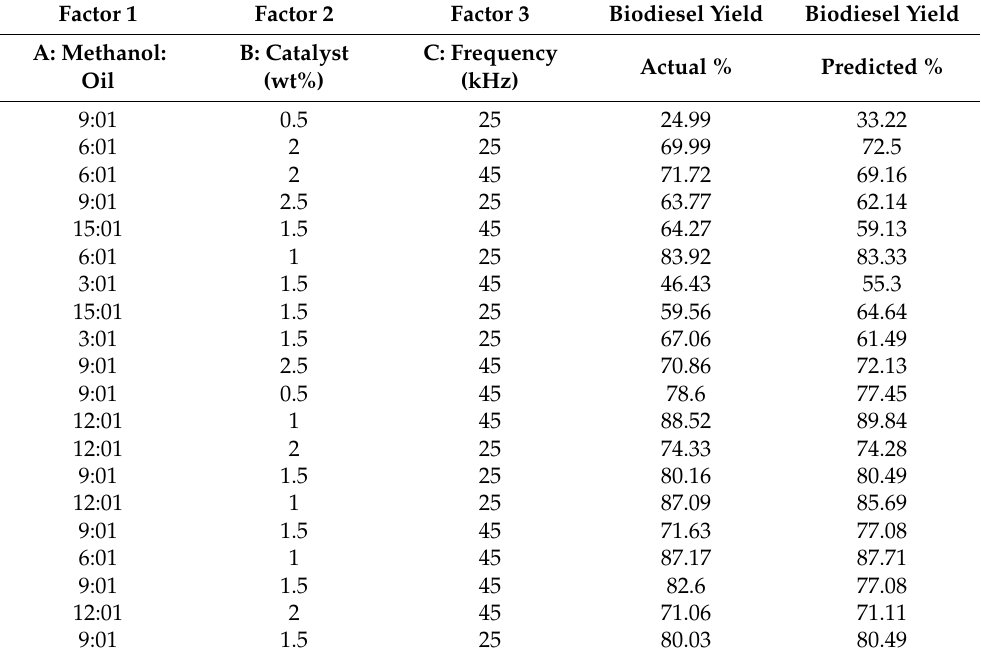
Table 3. CCD experimental design